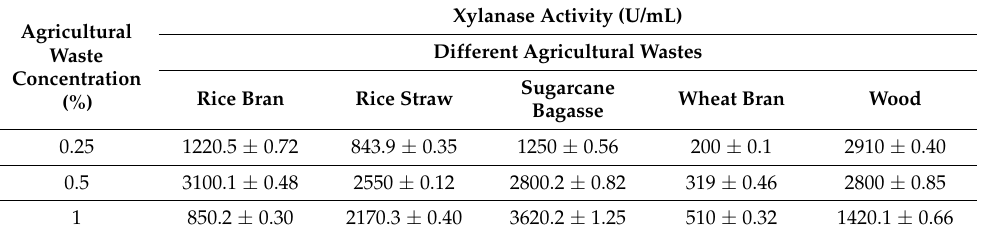
Mannose + malt extract 1430 ± 1.4 All results are reported as the mean ± standard error (significance p < 0.05). Table 3. The consequence of using some agricultural wastes on xylanase activity by Trichoderma harzianum